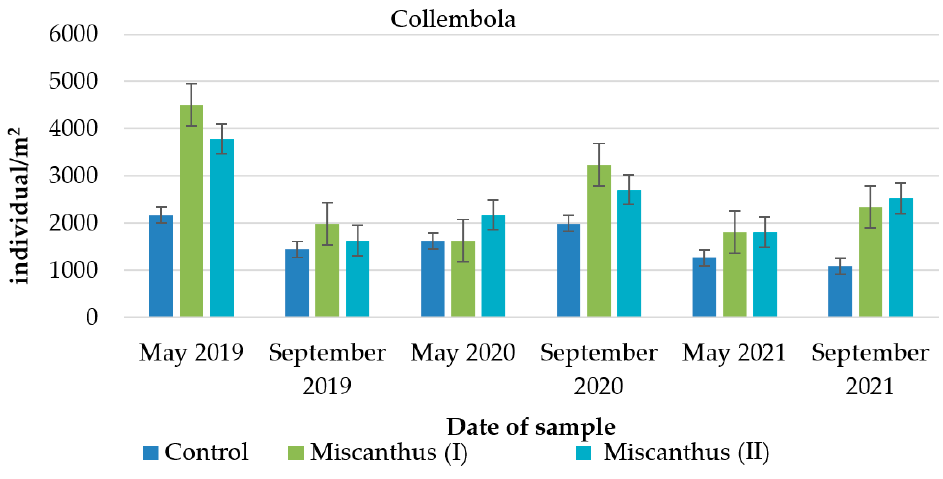
Figure 6. The number of colemboles on chernozem under Miscanthus : May 2019– НIР 05 = 362; Sep- НIР 05 = 204; September 2019– НIР 05 = 192. Source: own research